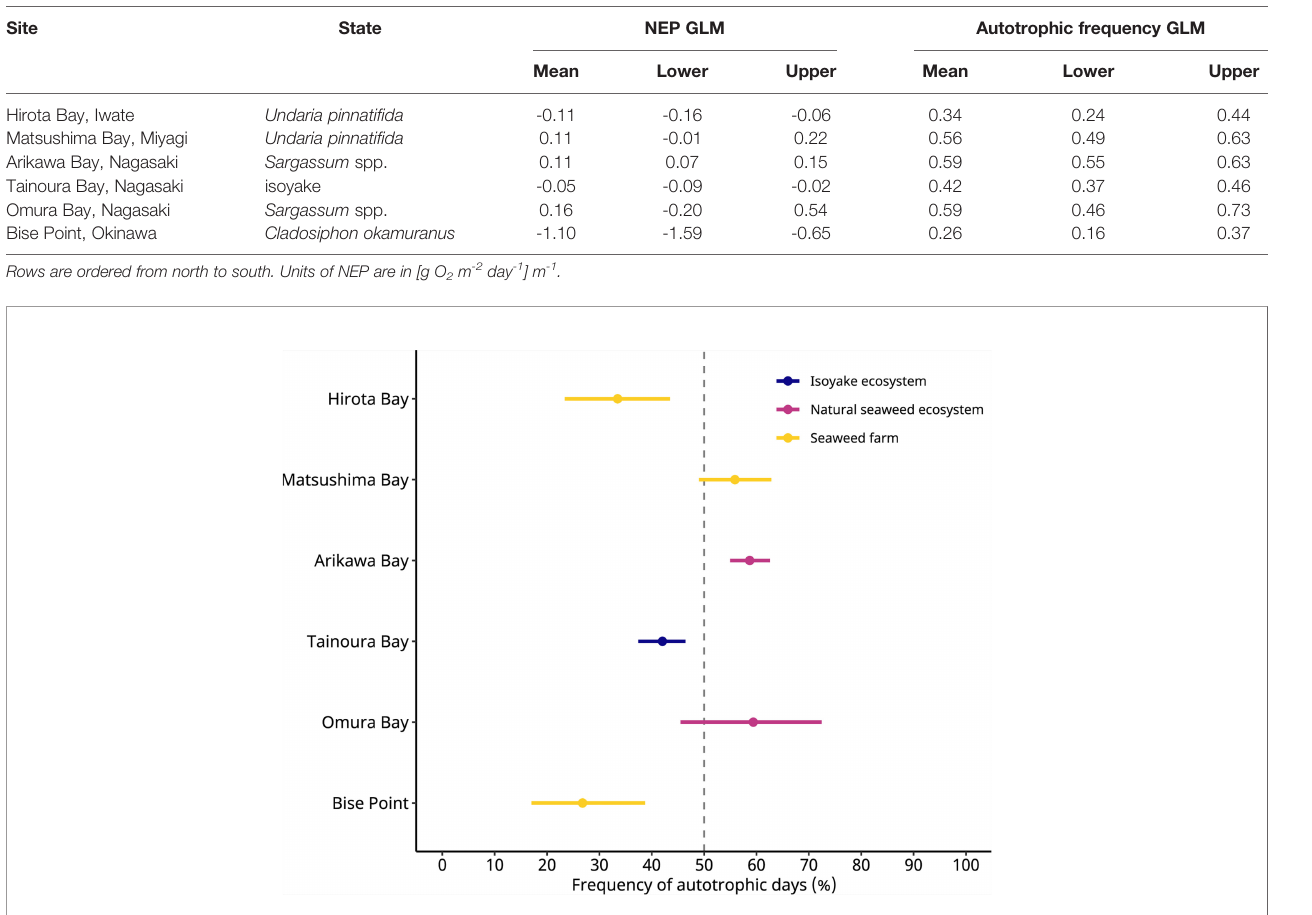
FIGURE 3 | The frequency of autotrophic days predicted by a generalized linear model. The colored points indicate the predicted values, and the colored lines indicate the 95% highest density credible interval. Hirota Bay and Matsushima Bay are the Undaria pinnati fi da aquaculture farms, Bise Point is the Cladosiphon okamuranus aquaculture farm, Arikawa Bay and Omura Bay are sites of the natural Sargassum spp. ecosystem, and Tainoura Bay is a site where a seaweed ecosystem has degraded into an isoyake state.